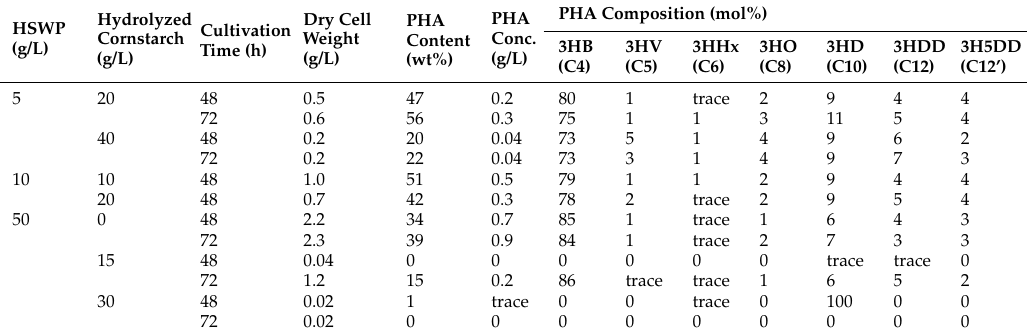
Table 7. Biosynthesis of PHA in Pseudomonas sp. 61-3 ( phbC :: tet ) harboring pJKSc54- phab from HSWP and hydrolyzed